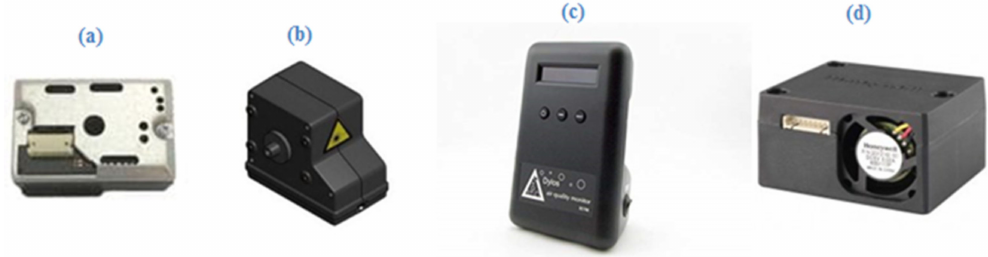
Figure 2. The COTS sensors that were used for the measurements: ( a ) Sharp-GP2Y1030AU0F; ( b ) OPC-N3; ( c ) Dylos DC1700; ( d ) Honeywell